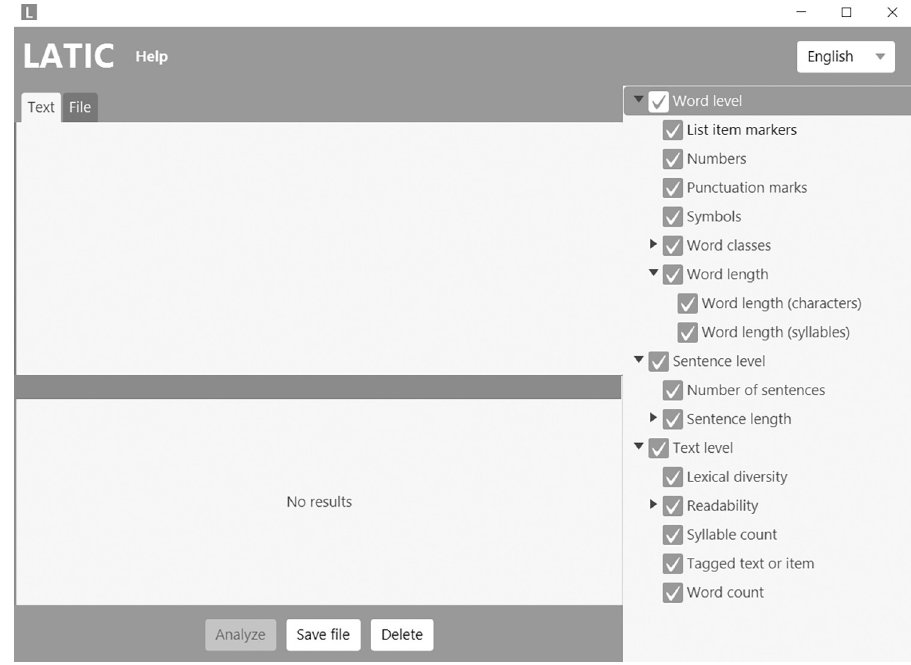
Fig 1. User Interface of LATIC (Version